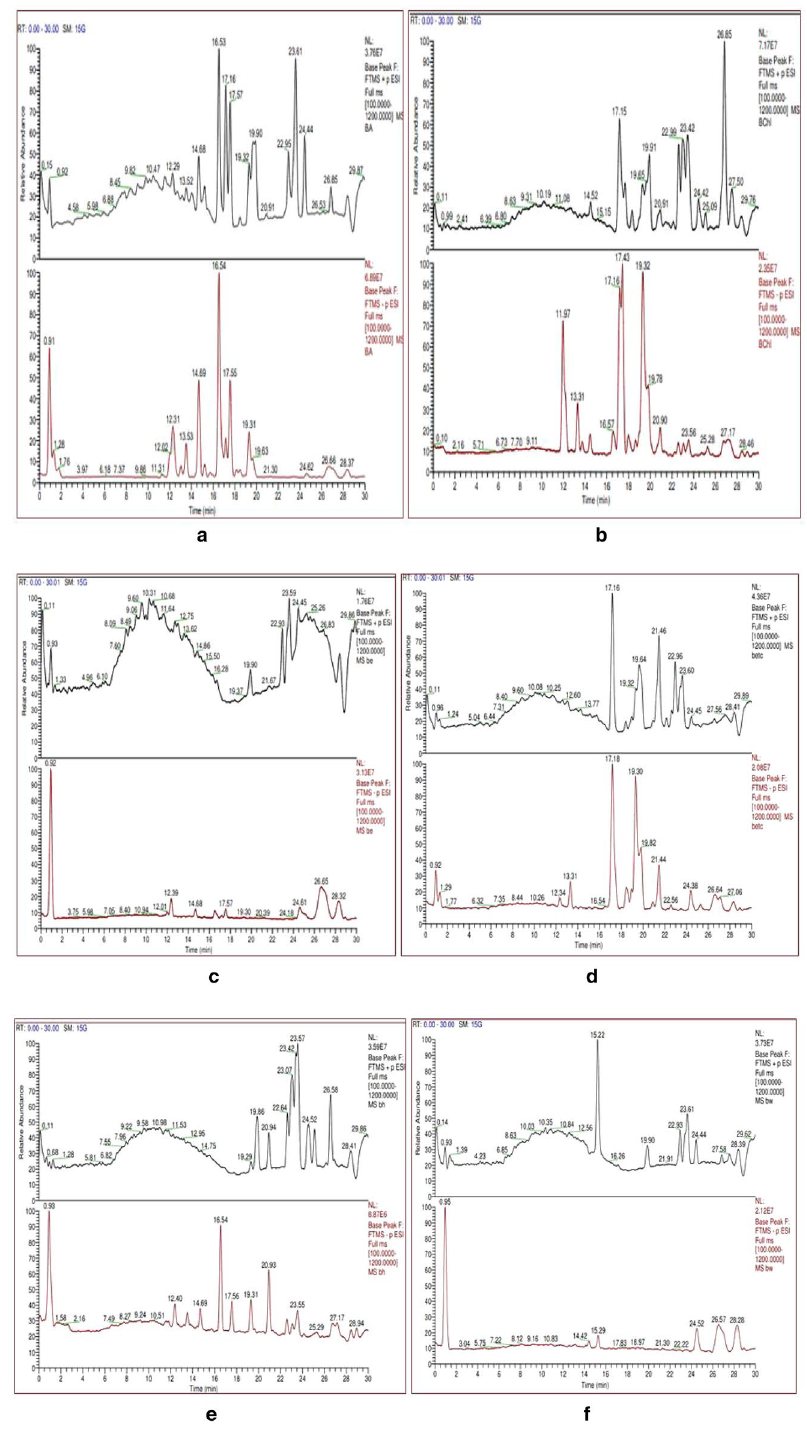
Figure 6. ( a ) Chromatogram for Acet-AB and ( b ) for Chlo-AB. ( c ) Chromatogram for Etoh-AB and ( d ) for Dw-AF. ( e ) Chromatogram for Hex-AB and ( f ) for Meoh-AB. ( g ) Chromatogram for Dw-AB and ( h ) for Acet-AF. ( i ) Chromatogram for Chlo-AF and ( j ) for Etoh-AF. ( k ) Chromatogram for Etac-AF and ( l ) for Hex-AF. ( m ) Chromatogram for Meoh-AF and ( n ) for Acet-AL. ( o ) Chromatogram for Etoh-AL and ( p ) for Etac-AL. ( q ) Chromatogram for Hex-AL and ( r ) for